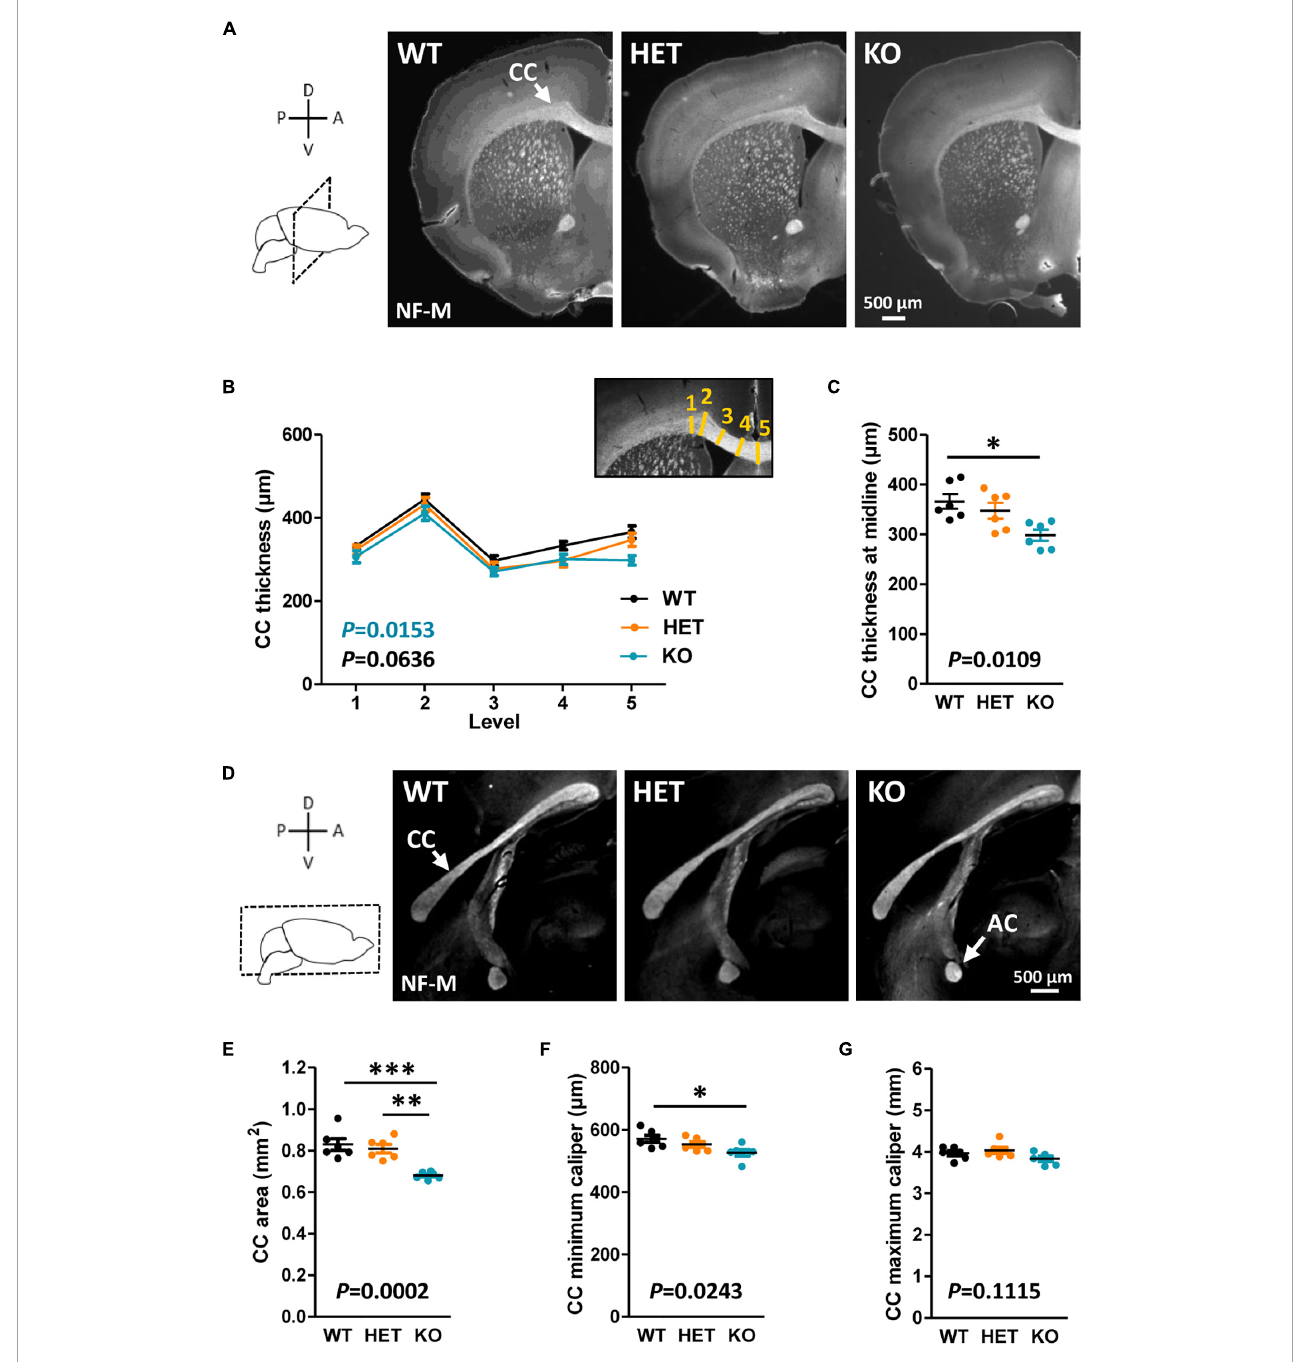
FIGURE1 Corpus callosum (CC) morphology in adult mice. Representative images of brain coronal sections (Bregma + 0.50) of wild-type (WT), HET, and KO P90 mice showing CC immunostained with anti-NF-M antibodies (A) . CC thickness measured at different levels on coronal sections (B) ; inset, schematic representation of the levels (yellow lines) where CC thickness measurements were performed. CC thickness at the midline of the brains (C) . Representative images of mid-sagittal brain sections of WT, HET, and KO P90 mice, showing the CC and the AC immunostained with anti-NF-M antibodies (D) . CC area (E) , minimum caliper (F) , and maximum caliper (G) measured on mid-sagittal brain sections. (B,C,E–G) Six animals/genotype, (B) average of measurements on both hemispheres on three consecutive sections/animal, (C,E–G) average of measurements on three